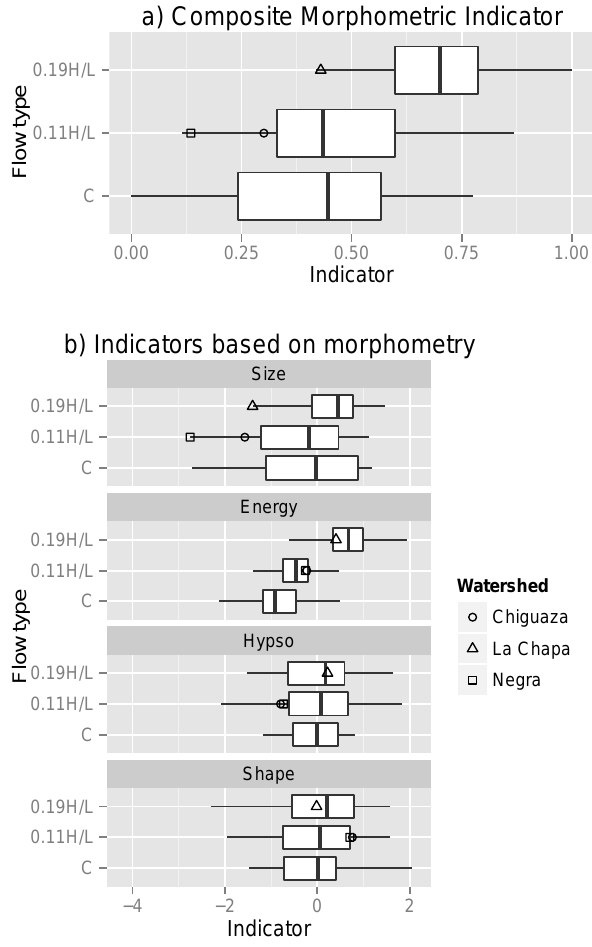
Figure 13. (a) Composite morphometric indicator, (b) indicators based on morphometry. Note that 0.19 H/L and 0.11 H/L corre- spond to watersheds that can propagate debris flows to their fans considering angles of reach of 0.19 and 0.11,